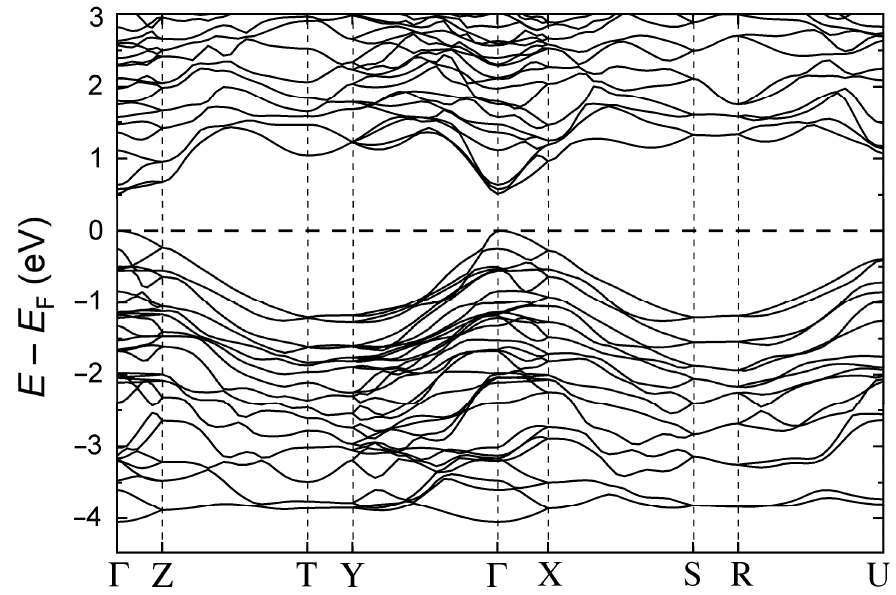
Figure 3. The electronic band structure of Ca 3 InAs 3 . The Fermi level is taken as a reference at 0 eV and represented with a dashed line. The opening of a bandgap of ca. 0.46 eV at the Γ point is suggestive of an intrinsic, direct gap semiconductor.